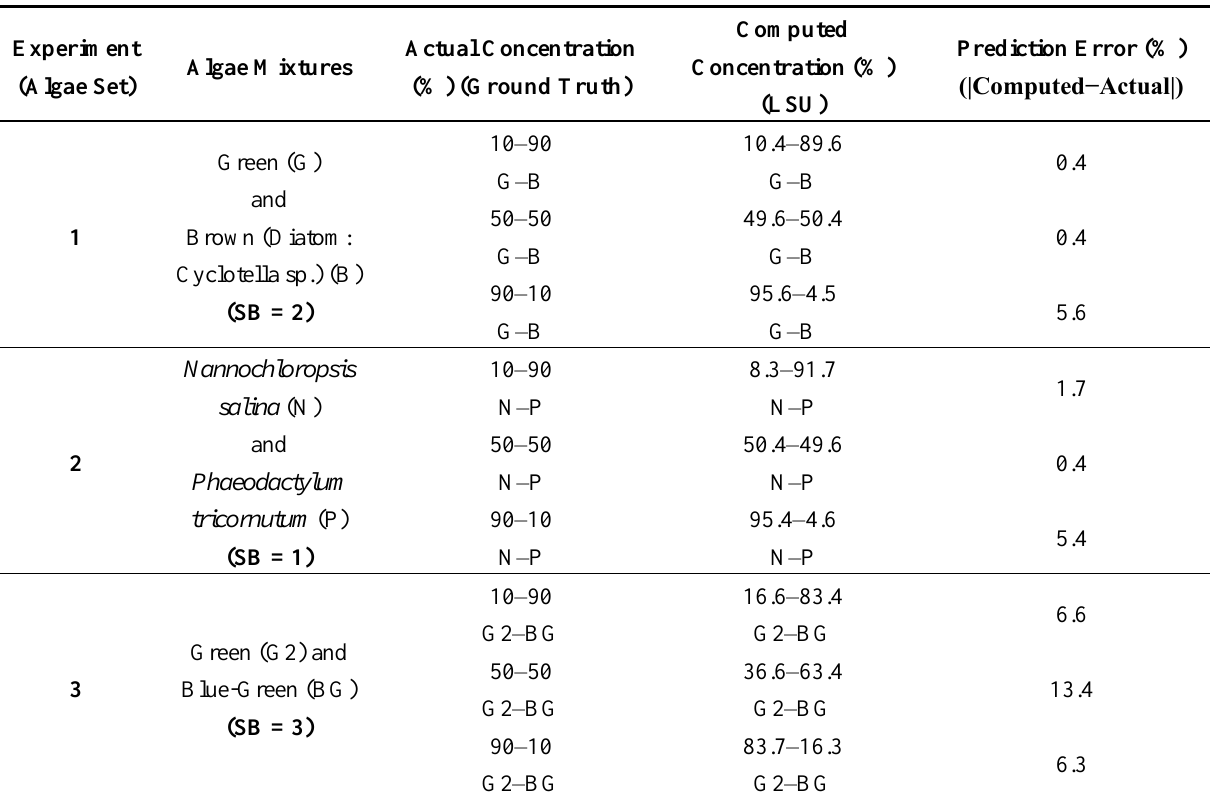
Table 1. Actual and computed algae concentrations via linear spectral unmixing (LSU) and minimum RMS error. A variety of algal species were tested in three experiments under different settings for spectral binning (SB). (Nanno: Nannochloropsis salina ; Phaeo: Phaeodactylum tricornutum ; Green: coccoid cyanobacteria of green and brown plant lines (two separate green algae used in Experiments 1 and 3); Brown: diatom (Cyclotella sp.)) Concentrations are listed by mixed